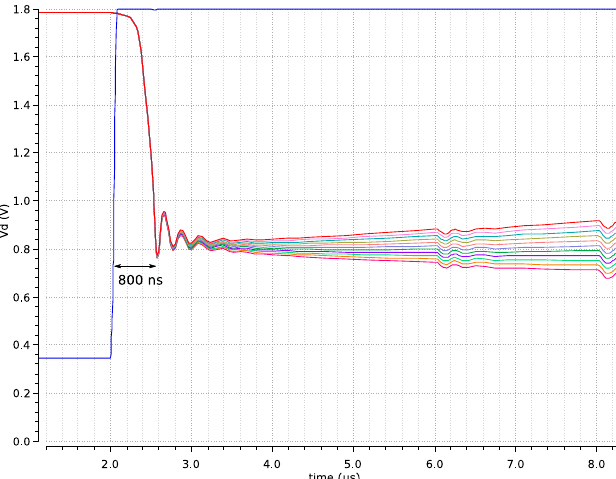
Figure 7. Worst case when there is a clear single winner, it is selected, and all other pixels fight to become the winner.